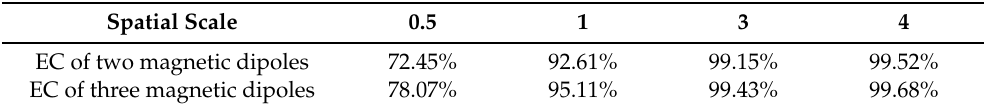
Table 1. Comparison of the equivalent consistency of the total magnetic field between two or three magnetic dipoles and a single magnetic dipole with different spatial scales.